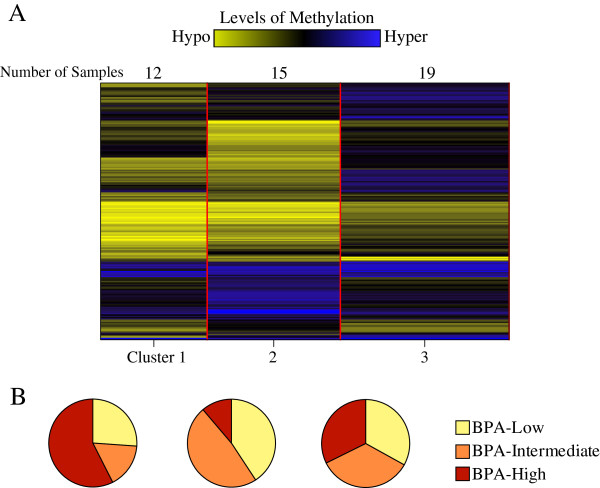
The 200 most variable CpG sites from 46 samples were clustered using Recursively Partitioned Mixture Model (RPMM) for Beta and Gaussian Mixtures from R package, a model-based clustering algorithm that returns a hierarchy of classes, similar to hierarchical clustering and finite mixture models. (A) RPMM clustering divided 46 samples into 3 clusters (1, 2, and 3), containing 12, 15, and 19 samples, respectively. (B) More than half of the BPA-high samples were clustered within cluster 1, while BPA-low and –intermediate samples were more evenly distributed across all 3 clusters.